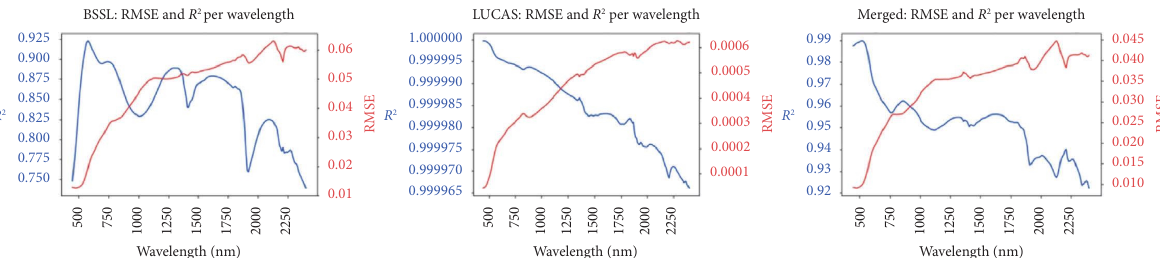
Figure 10: R 2 and the RMSE values per wavelength of the old–original vs. new raw spectral